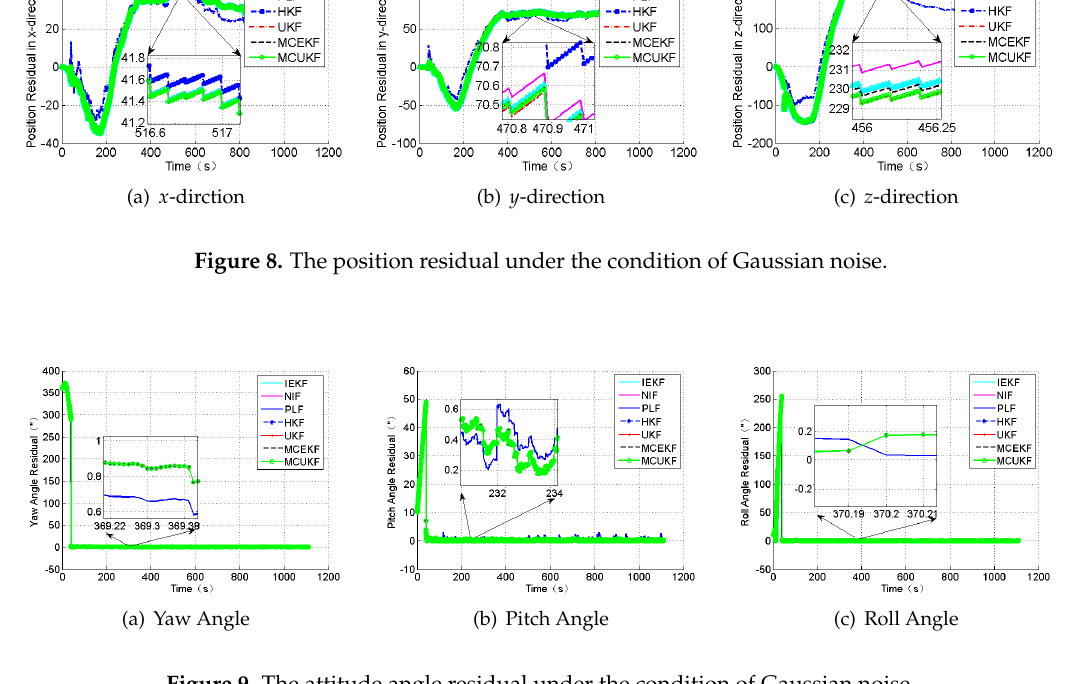
Figure 9. The attitude angle residual under the condition of Gaussian noise.